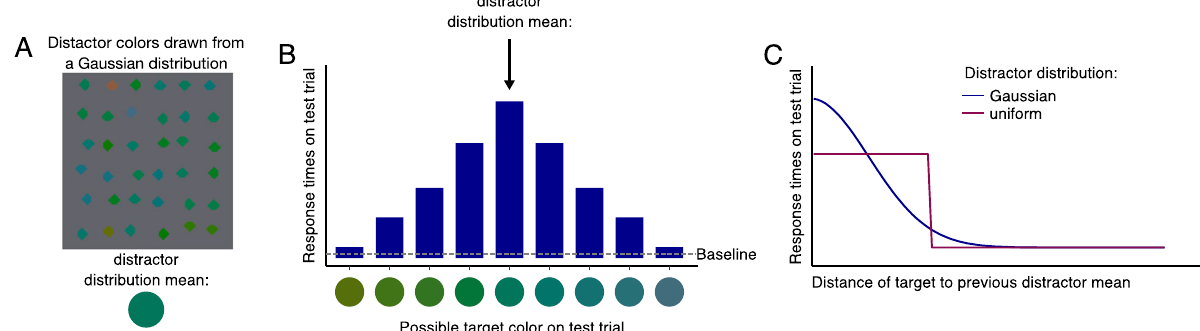
Figure 1. Hypothetical results using Feature distribution learning to assess internal representations of a feature distribution. ( A ) A distractor distribution is presented to the observer in a visual search task. ( B ) Shows a hypothetical response time pattern for different target colors. Response times for targets vary as a function of their probability on the learning trials. ( C ) Presenting many different targets will result in a response function corresponding to the internal representation of the distractors. The shape of that response function resembles the shape of the distractor